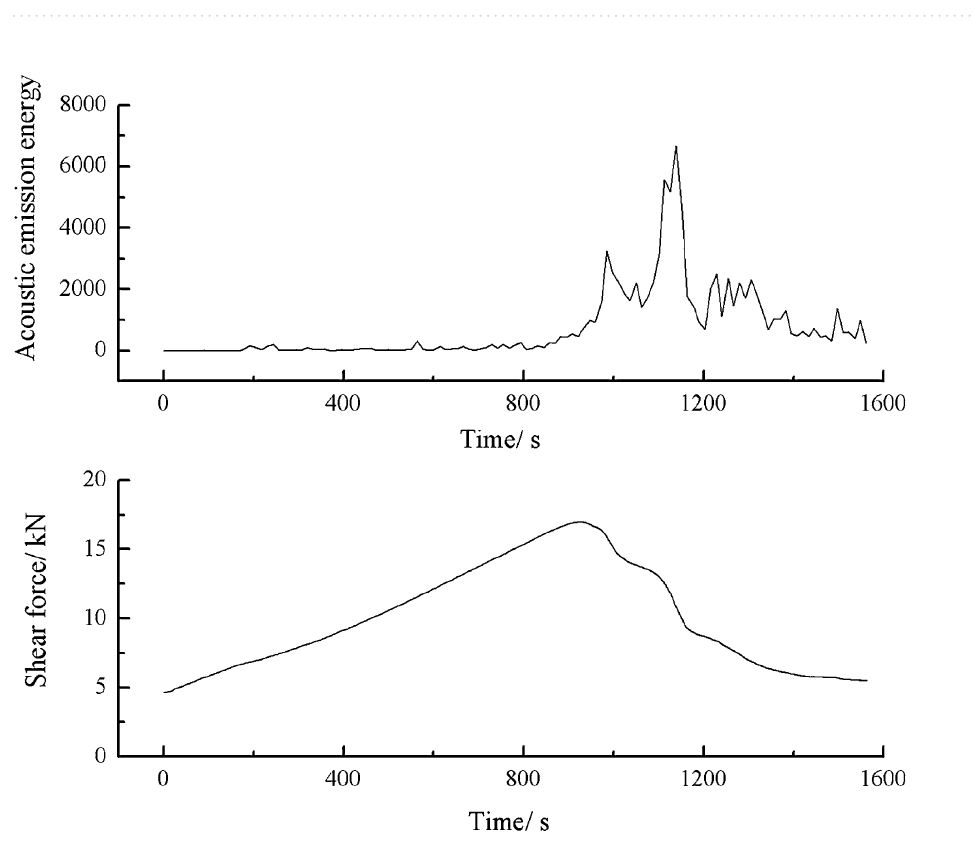
Figure 55. Shear stress–time and energy-time curves for a specimen containing 0–0.6 mm and 1–2.56 mm sand particles (two grain size